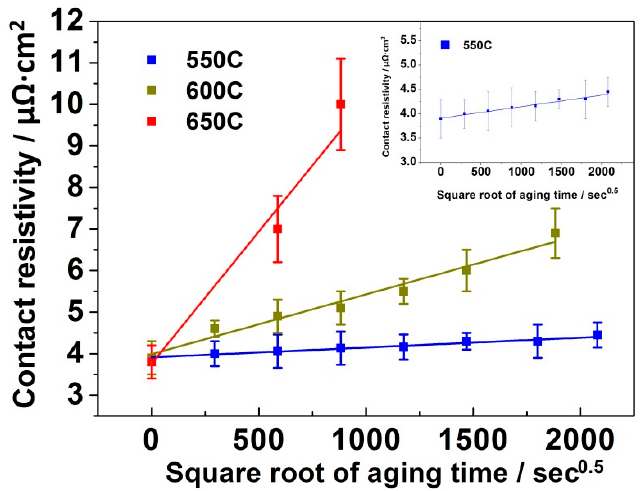
Figure 8. Variation of the interfacial contact resistivity of the joints with the square root of the aging time between 550 °C and 650 °C. Table 2. Fitting results of the relationship between the contact resistivity and the aging time, and predicted service life (The prediction is based on the assumption that a joint fails when the